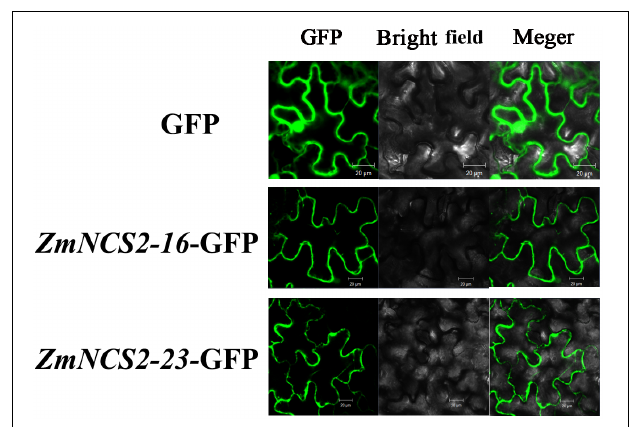
FIGURE 9 | Subcellular localization of ZmNCS2–16 and ZmNCS2–23. The control (GFP alone) signal was detected throughout the cell, while the ZmNCS2–16 -GFP and ZmNCS2–23 -GFP signals were localized to the plasma